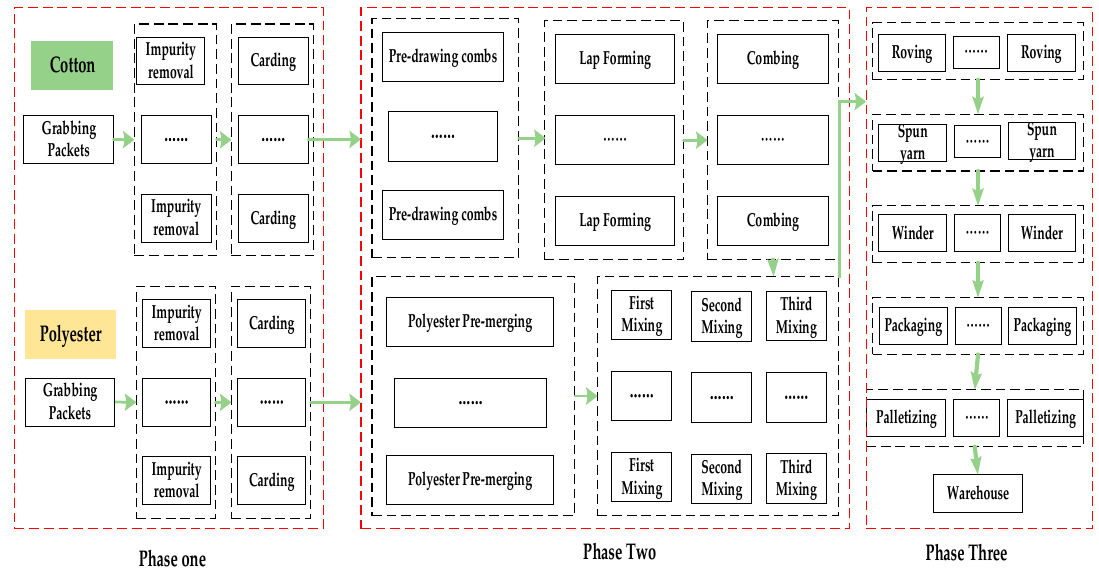
Figure 3. The production process of ring spinning in a spinning workshop.